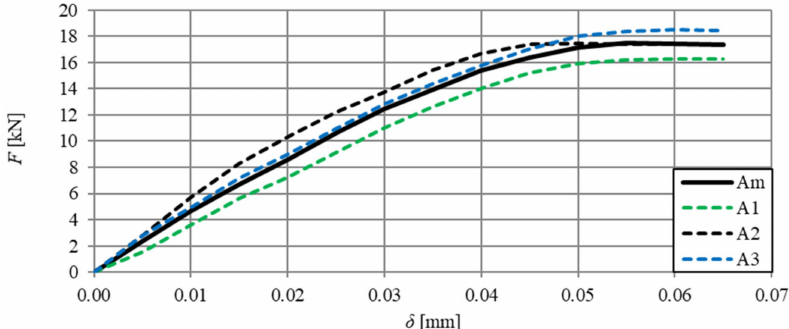
Figure 7. Force–deflection relationships for HSC beams (series A) and curve F– δ obtained on the basis of the arithmetic mean of results (continuous